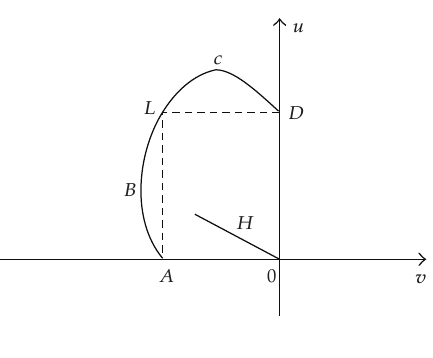
Figure 10: Relative position of curves L and H